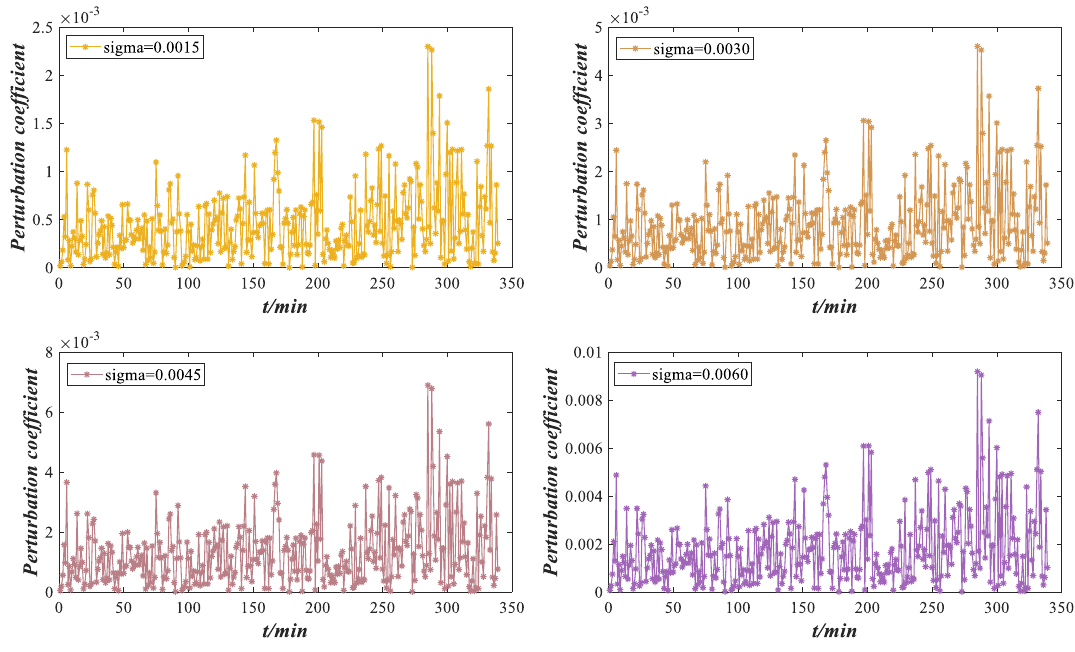
Figure 32. Perturbation coefficients under different perturbation